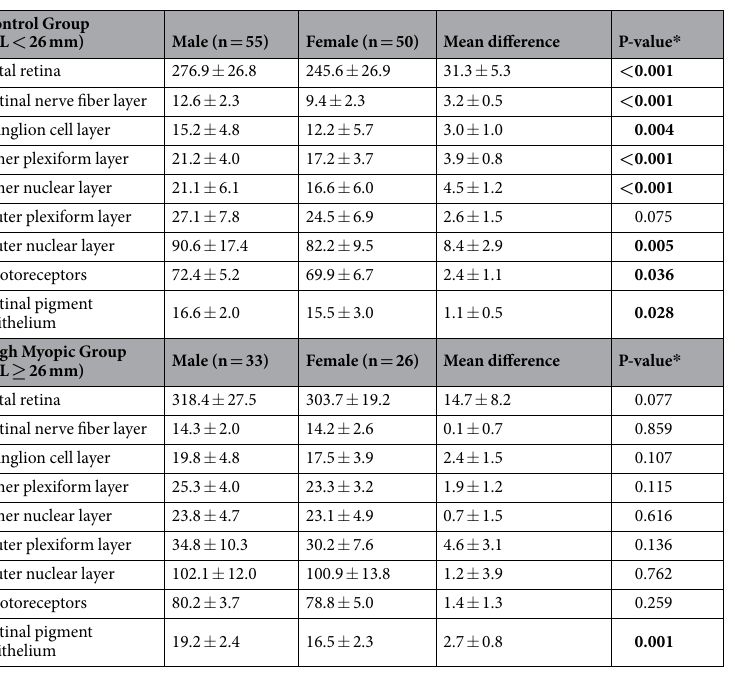
Table 3. Effect of sex on individual retinal layer thicknesses and axial length prolongation after ocular magnification adjustment. AL, axial length. Values are presented as mean thickness ± standard deviation ( µ m). P values were yielded by student t-test between male and female in each group divided by AL. * Bold values indicate statistically significant differences (P <